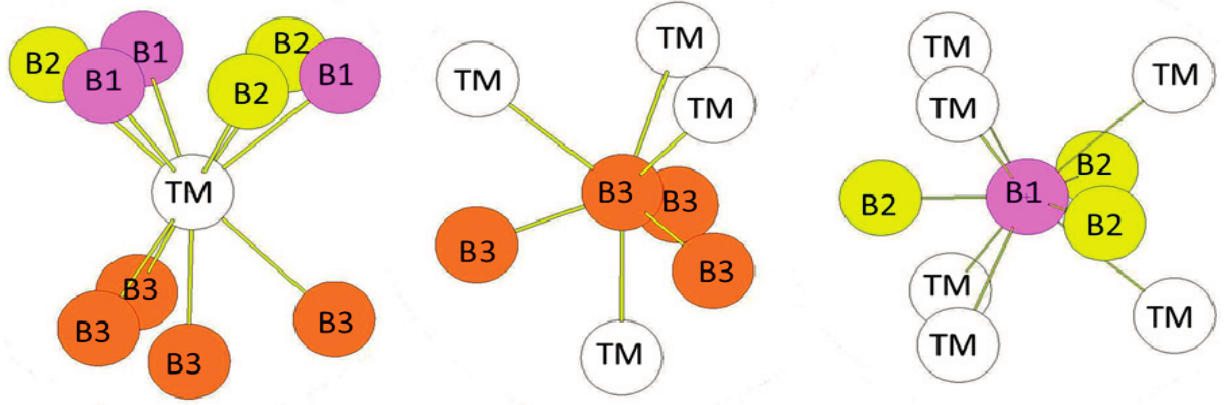
Figure 7. The environment of TM and B atoms in the hP12 (WB 2 -type) structure. The Wyckoff positions of B1, B2, and B3 atoms in the P63/mmc group space are 2b, 2c, and 4f respectively (see Table